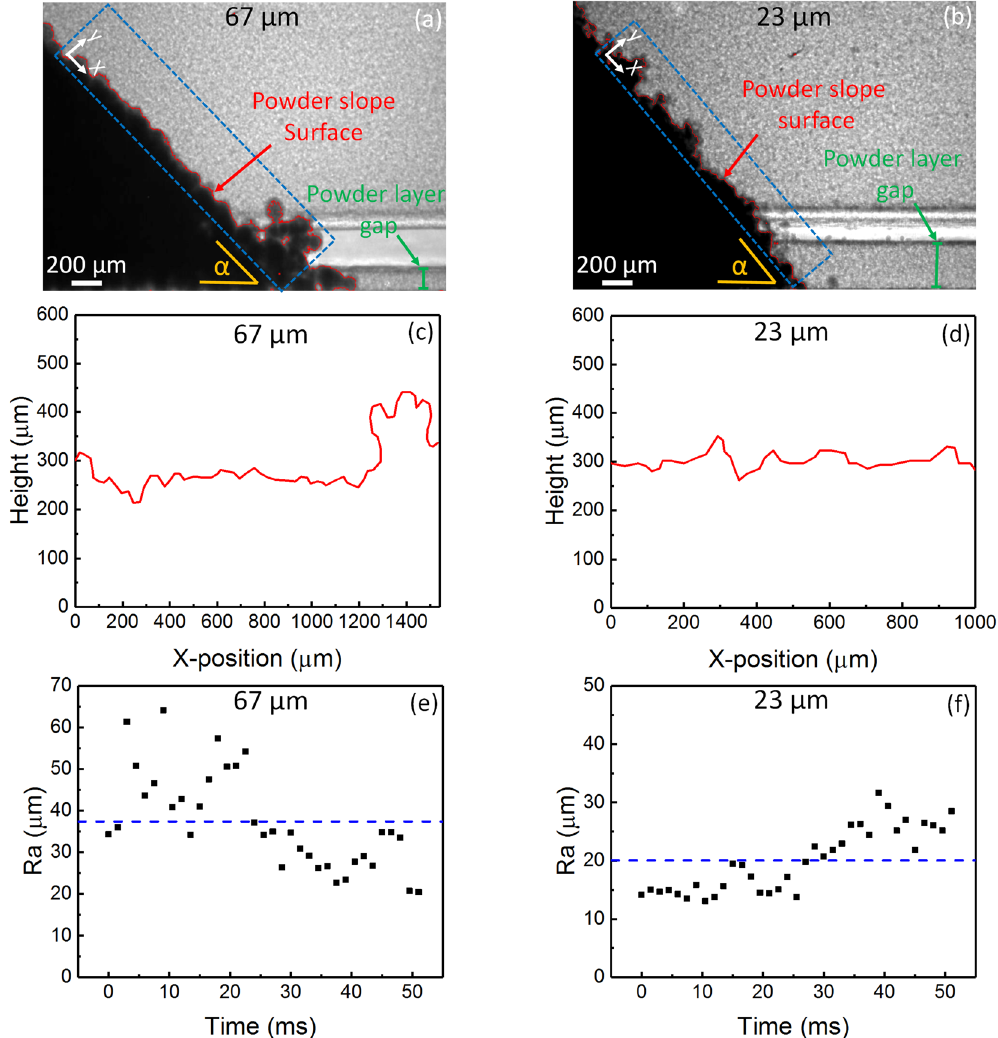
Figure 4. Slope surface roughness. ( a , b ) Representative x-ray images showing slope surface fluctuation of powders with an average diameter of 67 µ m ( a ) and 23 µ m ( b ). ( c , d ) Representative slope surface profile of powders with average diameters of 67 µ m ( c ) and 23 µ m ( d ). Height and X-position are measured with respect to the y-x coordinate shown in ( a , b ). ( e , f ) Arithmetic average slope surface roughness (Ra) versus time of powders with average diameters of 67 µ m ( e ) and 23 µ m ( f ). A total of 35 “Ra” measurements were obtained for each powder. A time lapse of 1.5 ms was used between each measurement. The powder with an average diameter of 67 µ m showed an average “Ra” of 38 µ m with a standard deviation of 11 µ m. The powder with an average diameter of 23 µ m showed an average “Ra” of 20 µ m with a standard deviation of 6 µ